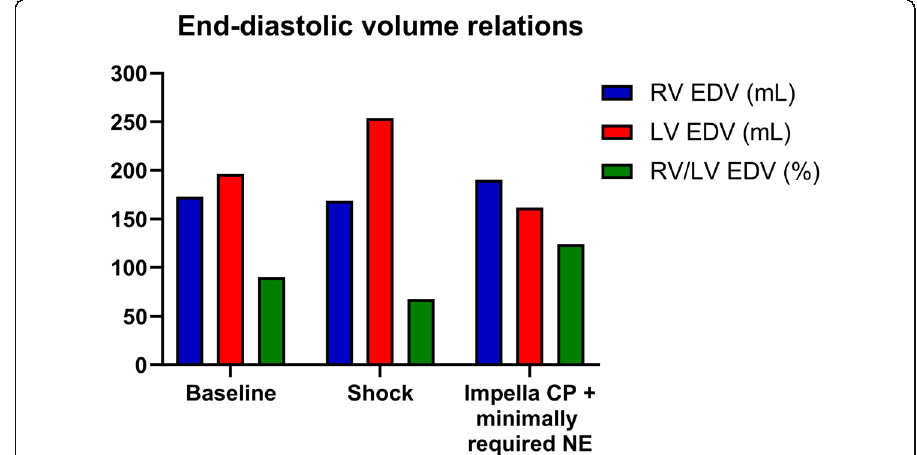
Fig. 2 Bar chart depicting end-diastolic volume relations between left and right ventricle at baseline, shock, and during Impella CP + minimum norepinephrine dose. EDV: end-diastolic volume, LV: left ventricle, NE: norepinephrine, RV: right ventricle